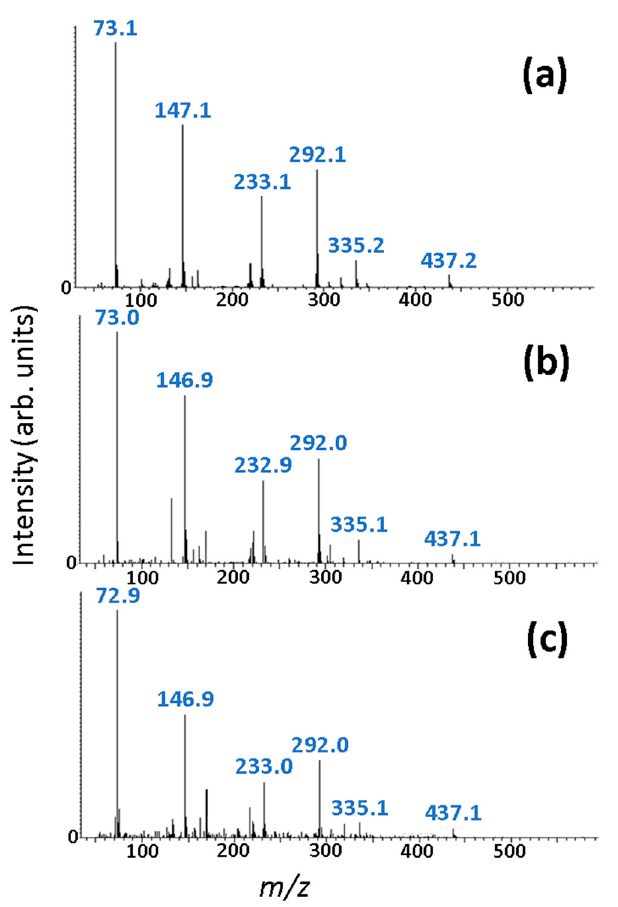
Figure 3. Mass spectrum of ( a ) standard sample of methyl tartaric acid, ( b ) DHPDA1 isomer present in toluene SOA (run 10), and ( c ) DHPDA2 isomer present in toluene SOA (run 10).